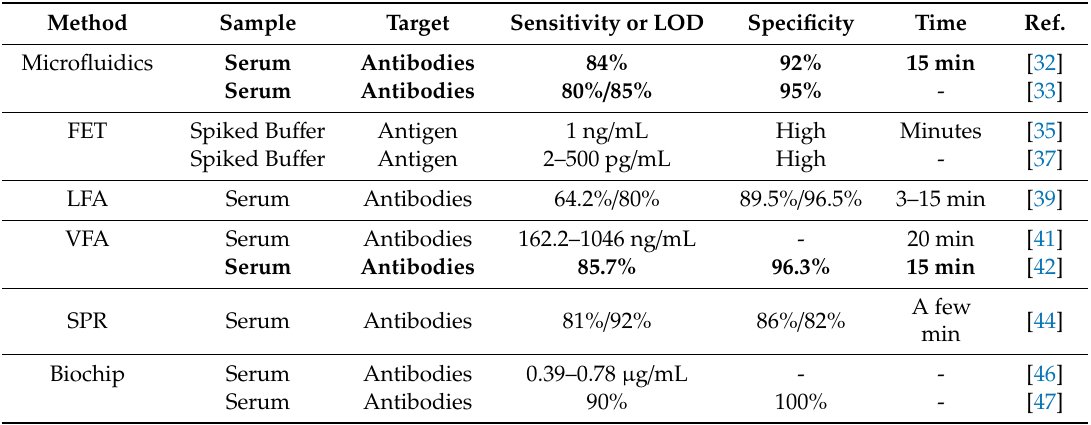
Table 1. Comparison of reported Lyme disease biosensors. Bold font represents biosensors tested specifically against early Lyme disease